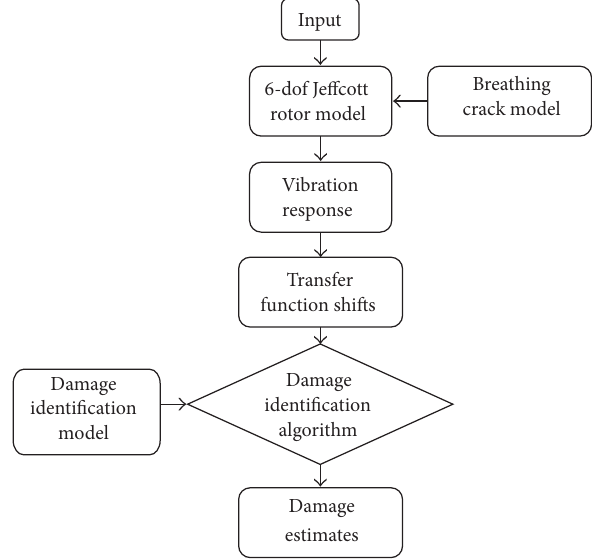
Figure 5: Damage identification workflow.